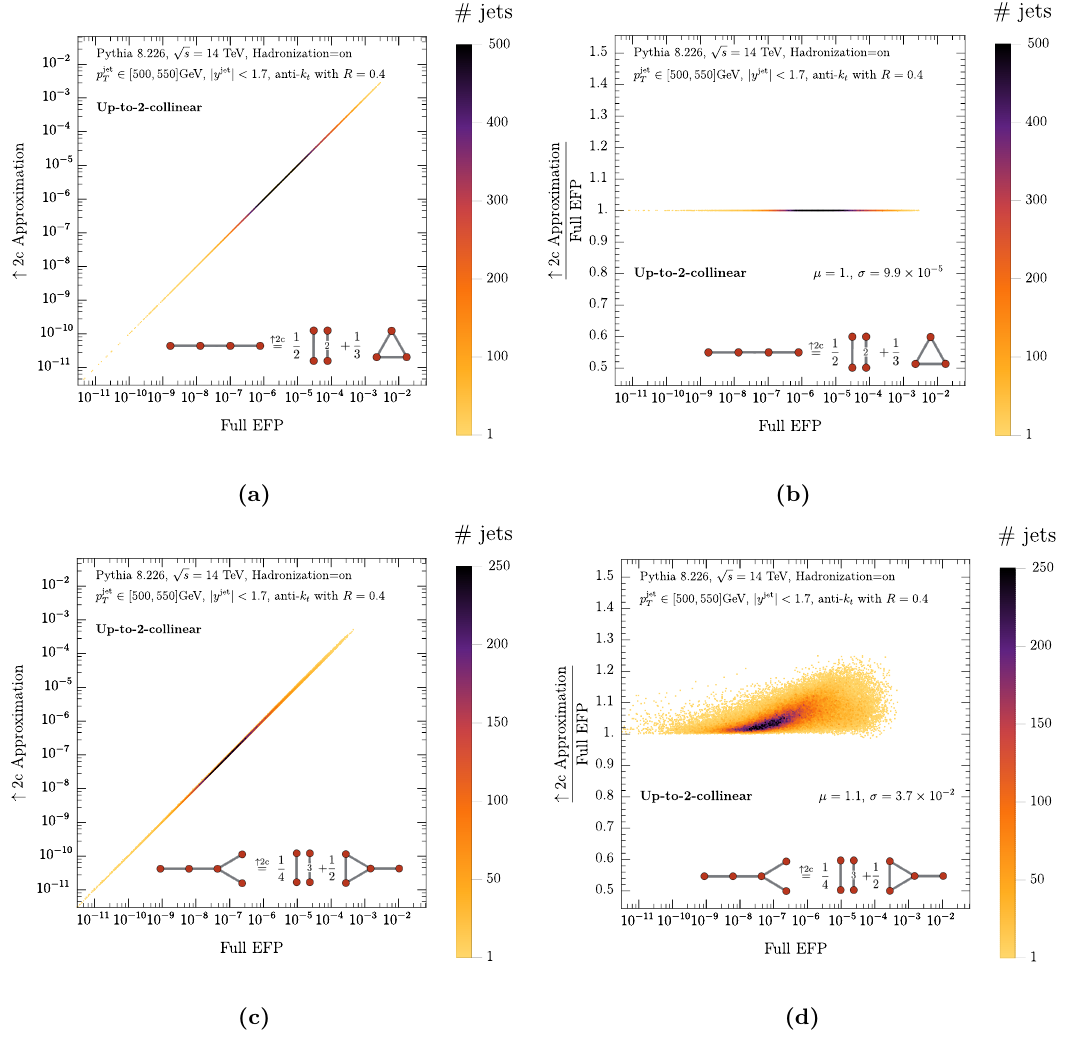
Figure 6. Same as figure 4, but using the relationships obtained from the up-to-2-collinear expan- sion, which are much more